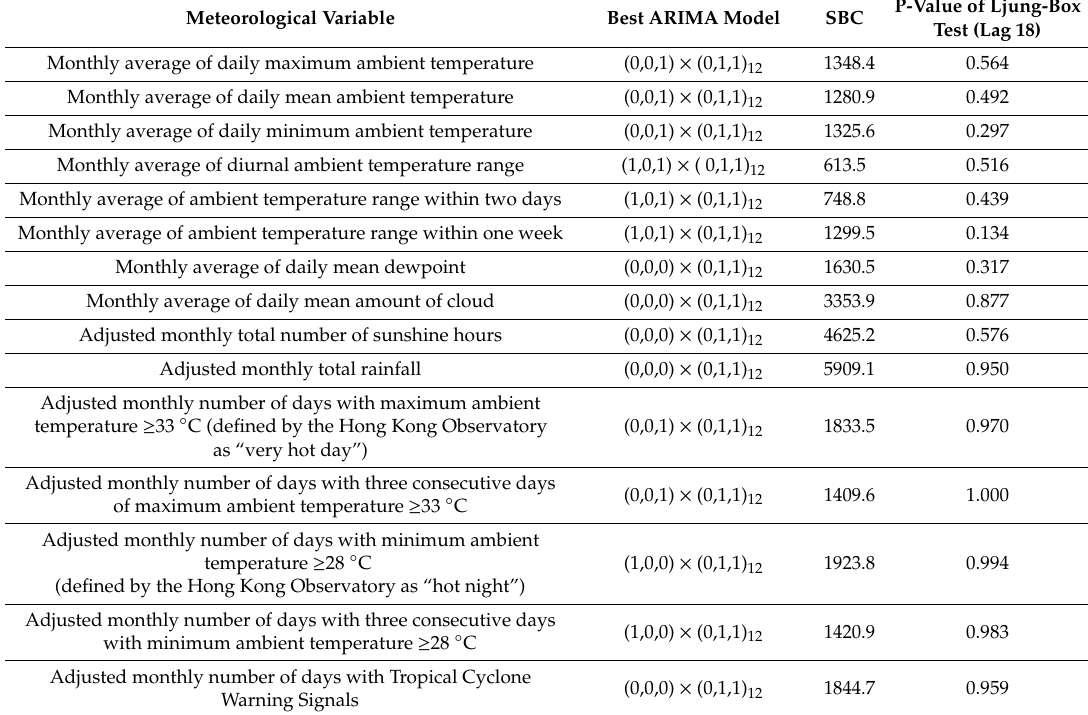
Table 2. ARIMA models for the meteorological variables related to hot